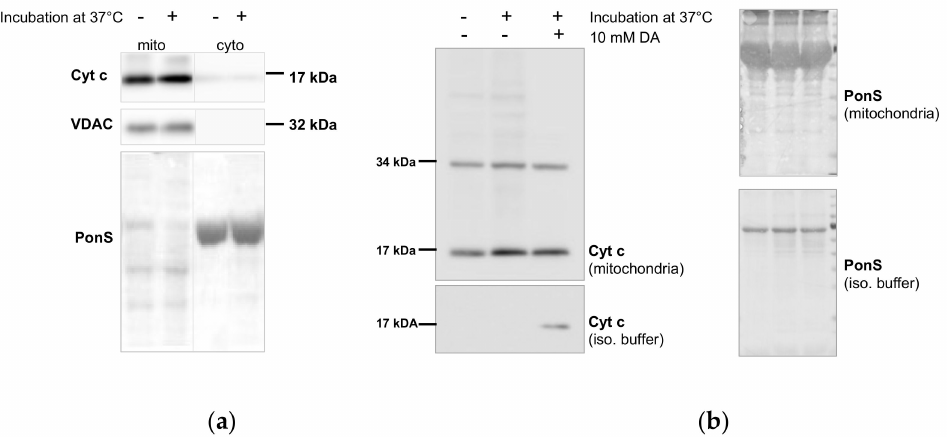
Figure A1. Effects of 30 min incubation at 37 ◦ C on the integrity of ( a ) cytosol-suspended or ( b ) isolation-buffer-suspended mitochondria. Cytochrome c was not released either from the cytosol- suspended or isolation-buffer-suspended mitochondria after 30 min incubation at 37 ◦ C. To confirm mitochondrial integrity during incubation, the levels of the VDAC were measured in the cytosol- suspended mitochondria; incubation did not change VDAC levels ( a ). In ( b ), a sample exposed to 10 mM DA served as positive control. Abbreviations: Cyt c, cytochrome c; DA, dopamine; iso. buffer, isolation buffer; PonS, Ponceau S (loading control); VDAC, voltage-dependent ion